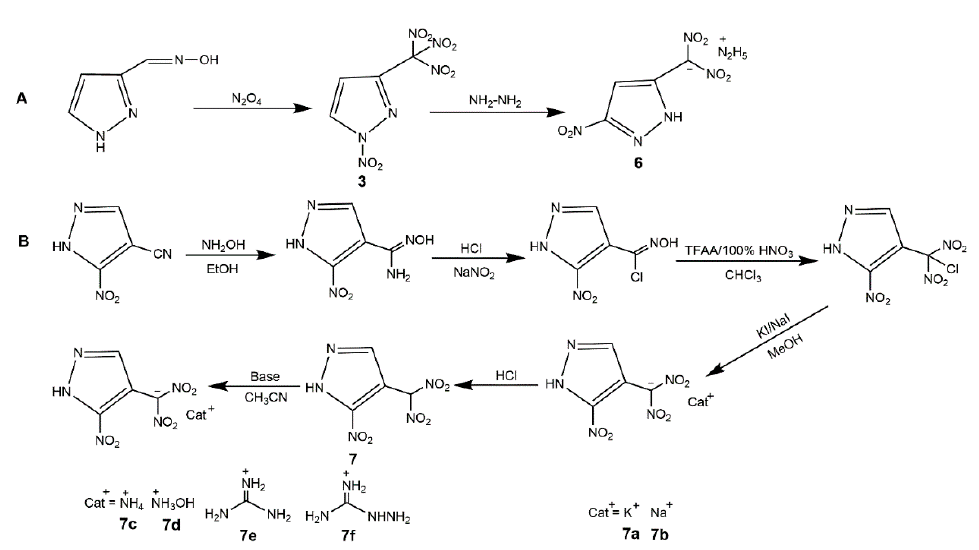
Figure 5. Synthesis of salts of trinitromethyl and dinitromethyl-substituted mononitropyrazoles.